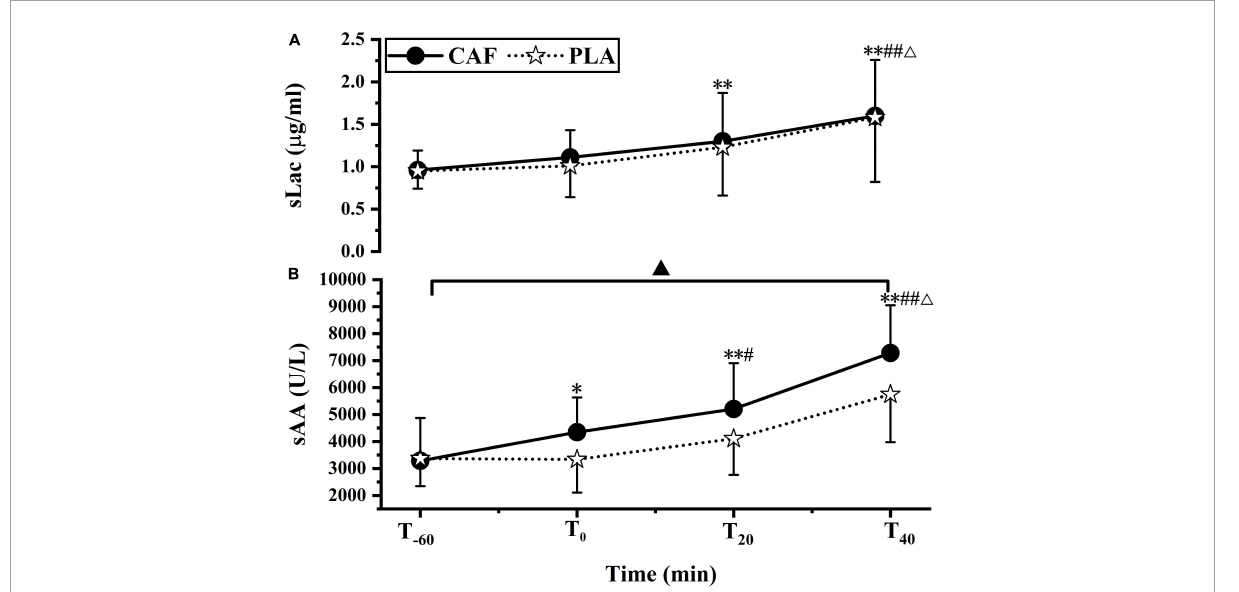
FIGURE2 (A) Salivary lactoferrin concentration, (B) salivary α -amylase activity responses to CAF and PLA. Values are means ± standard deviation ( n = 12). (cid:49) p < 0.01 vs. T (cid:78) p < 0.05 vs. ∗ p < 0.05, ∗∗ p < 0.01 vs. T - 60 ; # p < 0.05; ## p < 0.01 vs. T 0 ; 20 ,